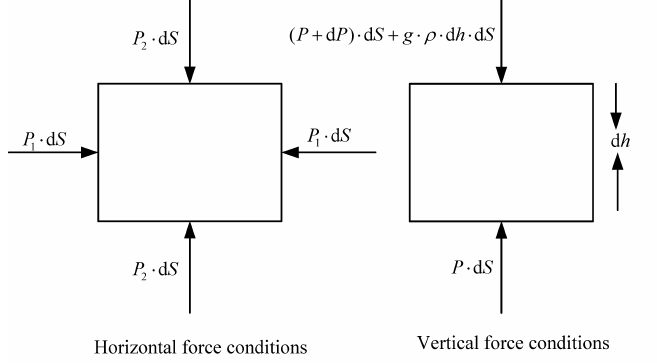
Figure 6. Force balance in the air in the stationary